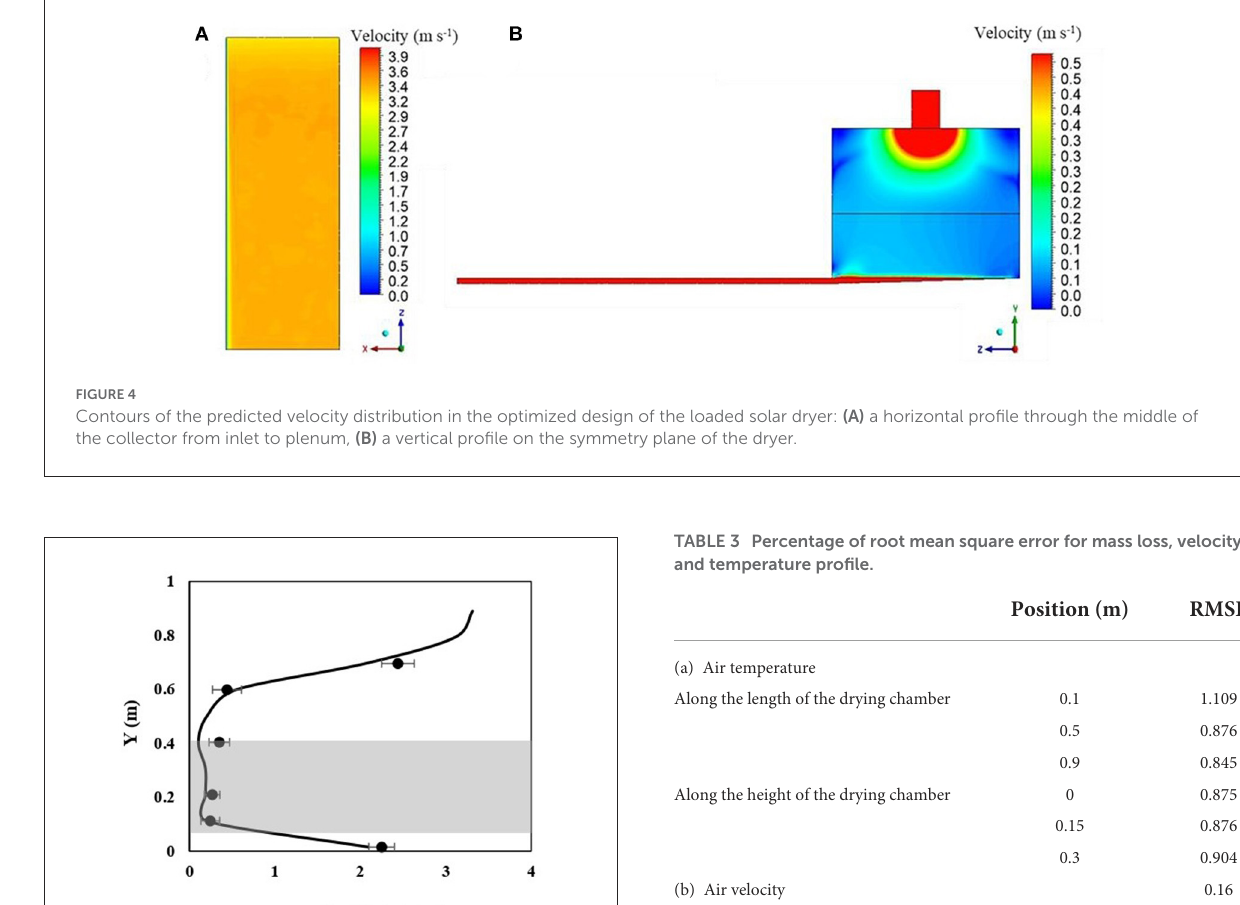
FIGURE5 Air velocity profile in the drying chamber along the height of the loaded solar dryer at a distance of 0.5m from the front side. The solid line and the symbols represent predicted and measured velocity profiles (error bars are standard error, n = 3), respectively. The shaded region indicates the area of the onion bulk layer.